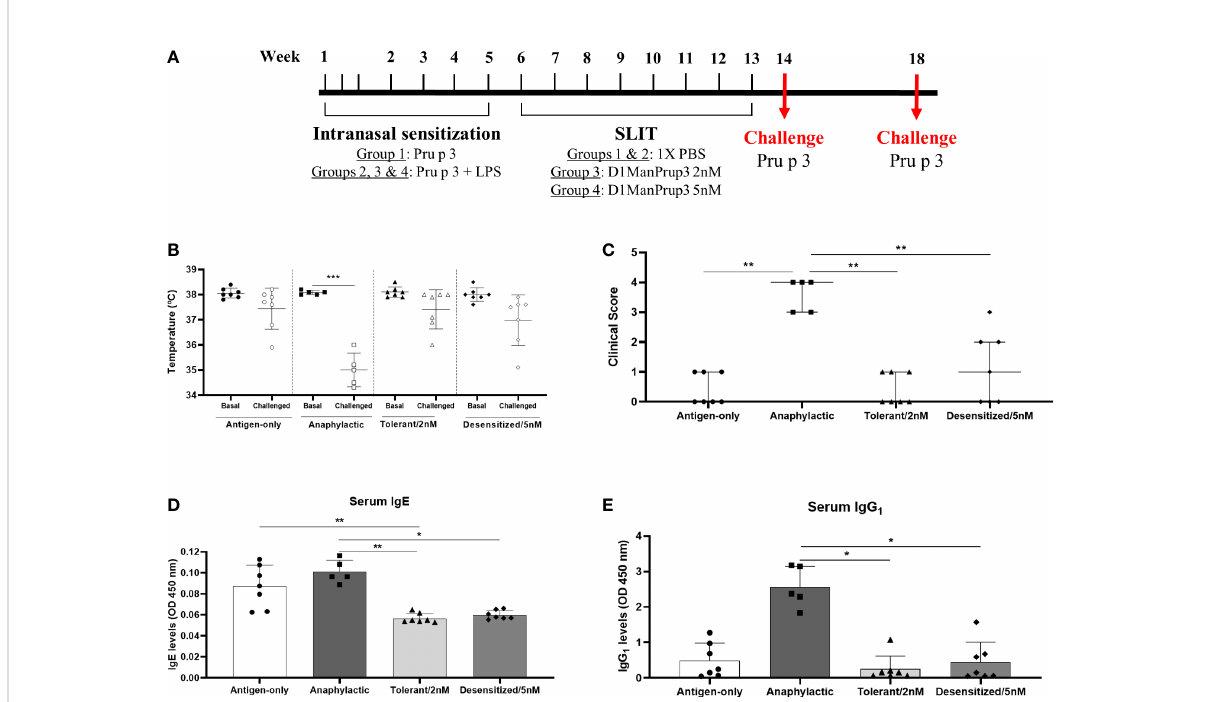
FIGURE 1 Establishment of anaphylactic mouse model and in vivo evaluation of anaphylaxis after SLIT. (A) Overview of the experimental design. Mice were sensitized with 20 µg of natural Pru p 3 (Antigen-only) or 20 µg of natural Pru p 3 plus 20ng LPS (the rest of groups), then SLIT was administered during 8 weeks, and challenge was performed one or fi ve weeks after fi nishing treatment. (B) Changes in temperature upon challenge in Antigen only, Anaphylactic, Tolerant/2nM and Desensitized/5nM groups. (C) Clinical symptoms upon challenge in Antigen only, Anaphylactic, Tolerant/2nM and Desensitized/5nM groups. (D) In vitro evaluation of Prup3-sIgE serum levels after challenge. (E) In vitro determination of Prup3-sIgG1 levels in serum from mice challenged. * p < 0.05; ** p < 0.01; *** p <